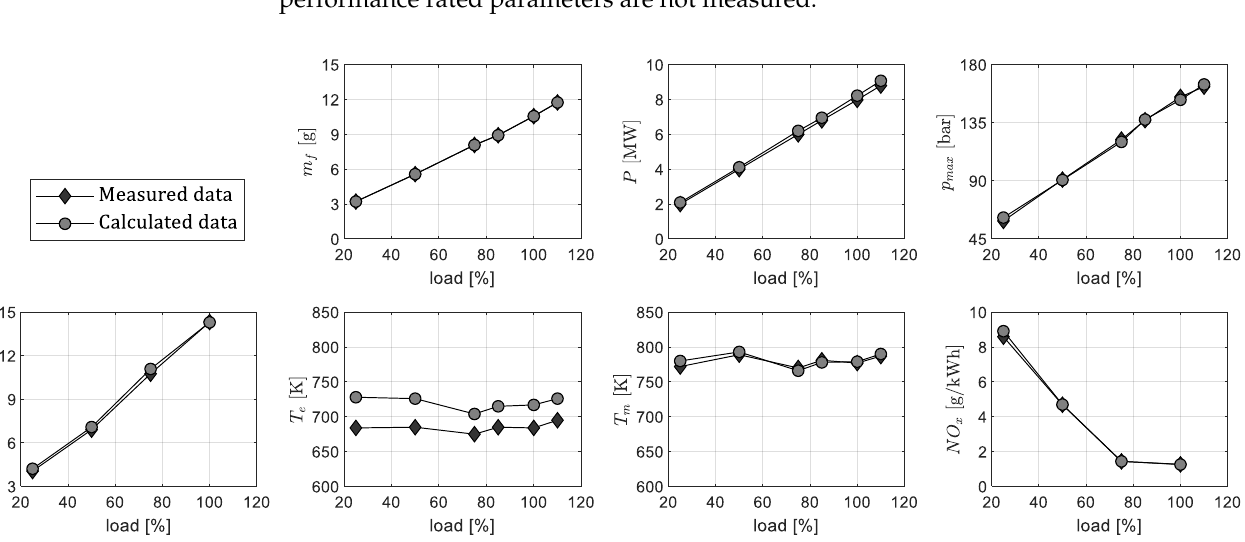
Figure 5. The calculated and measured results under gas fuel